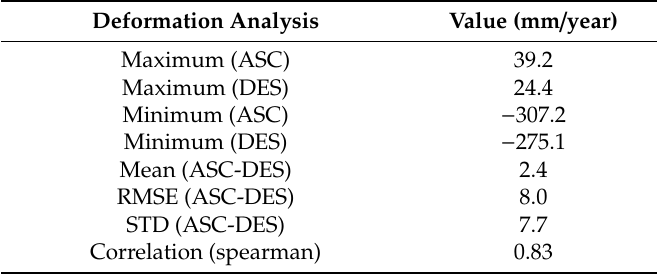
Figure 13. ( a ) Correlation of InSAR deformation rate between the ascending and descending tracks; ( b ) difference distribution statistics between ascending and descending tracks. Table 3. Statistics of deformation rate differences from two different tracks.